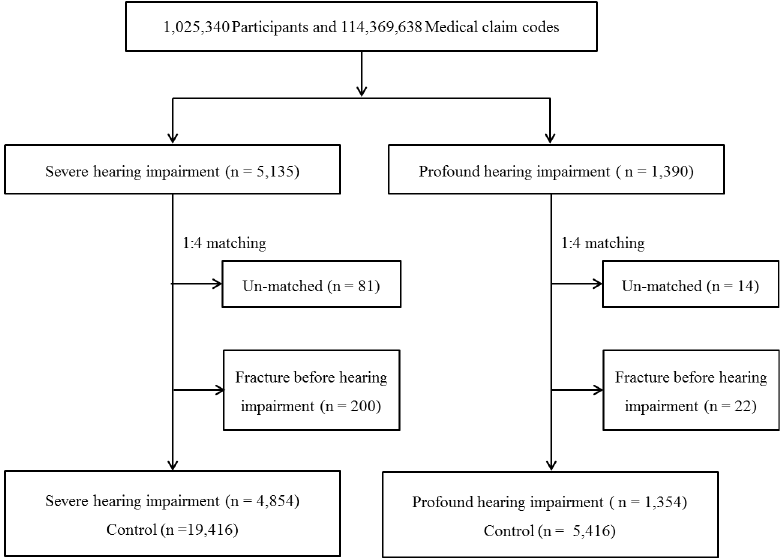
Fig 1. A schematic illustration of the participant selection process used in the present study. Out of 1,025,340 participants, 5,135 severe hearing-impaired and 1,390 profound hearing-impaired participants were selected. Hearing- impaired participants were matched 1:4 with a control group that did not have a hearing impairment diagnosis. Finally, 4,854 severe hearing impairment and 19,416 control participants were included as well as 1,354 profound hearing-impaired and 5,416 control